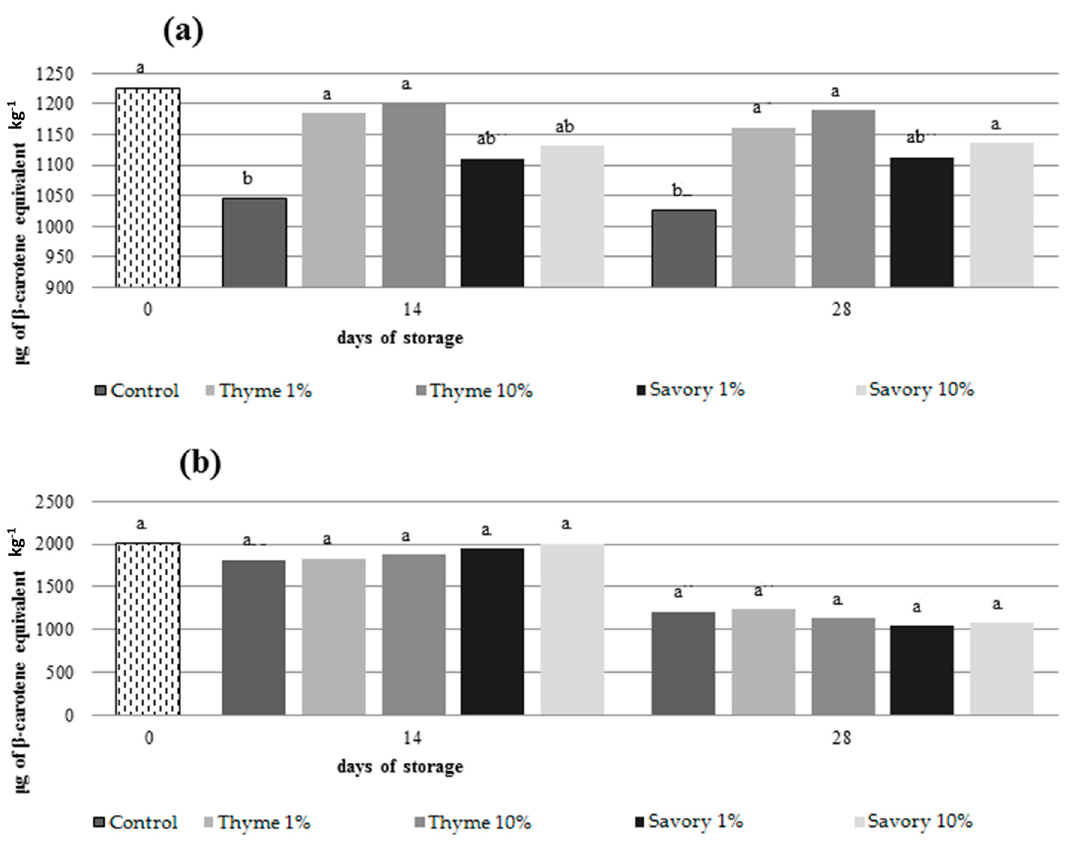
Figure 3. Total content of carotenoids in nectarines ‘Sweet Red’ ( a ) and peaches ‘Vista Rich’ ( b ) after 0, 14 and 28 days of cold storage. Mean values at the same time followed by the same letter are not significantly different by Tukey’s Test at p ≤ 0.05.